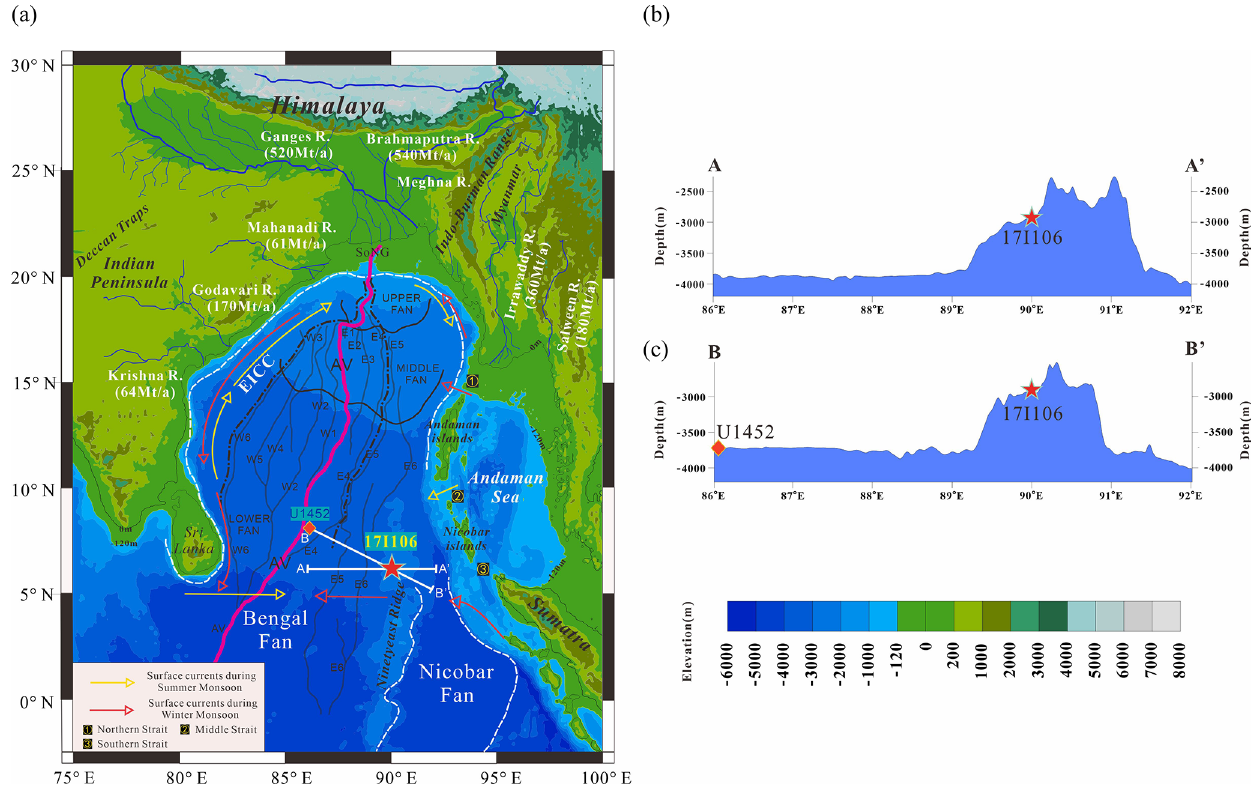
Figure 1. Geographical setting of the BoB. The locations of cores 17I106 (red asterisks) and U1452 (orange diamond) are shown. (a) The white dashed lines outline the scale of the Bengal Fan and the Nicobar Fan. The pink solid line is the “active” channel, and solid gray lines and black letters represent the turbidity channel and the reference names of the principal channels. The dotted–dashed line is the outline of the most recently active subfan (Curray et al., 2003). (b, c) The solid white lines denote the two profile positions with the elevation legend. Table 1. Carbon-14 and calibrated calendar ages of mixed planktonic foraminifera measured in core 17I106 in the northeastern Indian